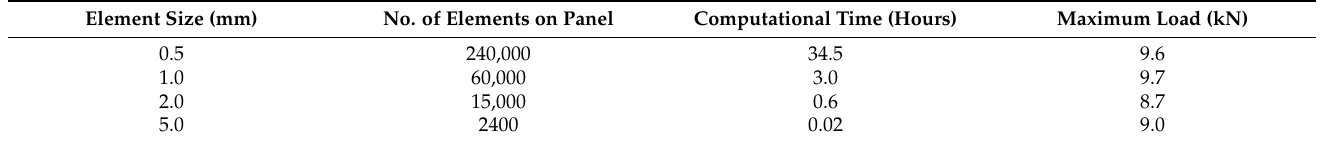
Table 5. Computational time vs. element size with respect to the maximum load.